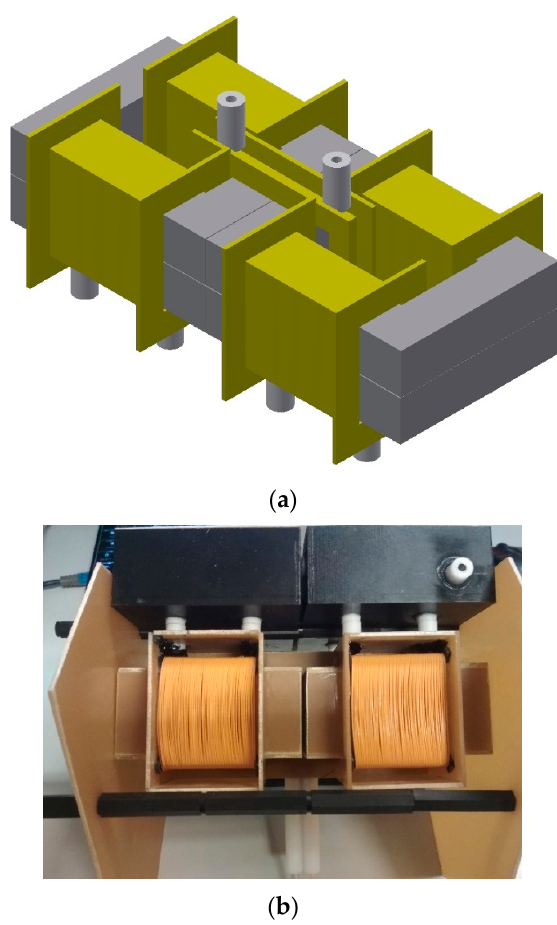
Figure 7. 3D visualization ( a ) and photo ( b ) of the transformer.